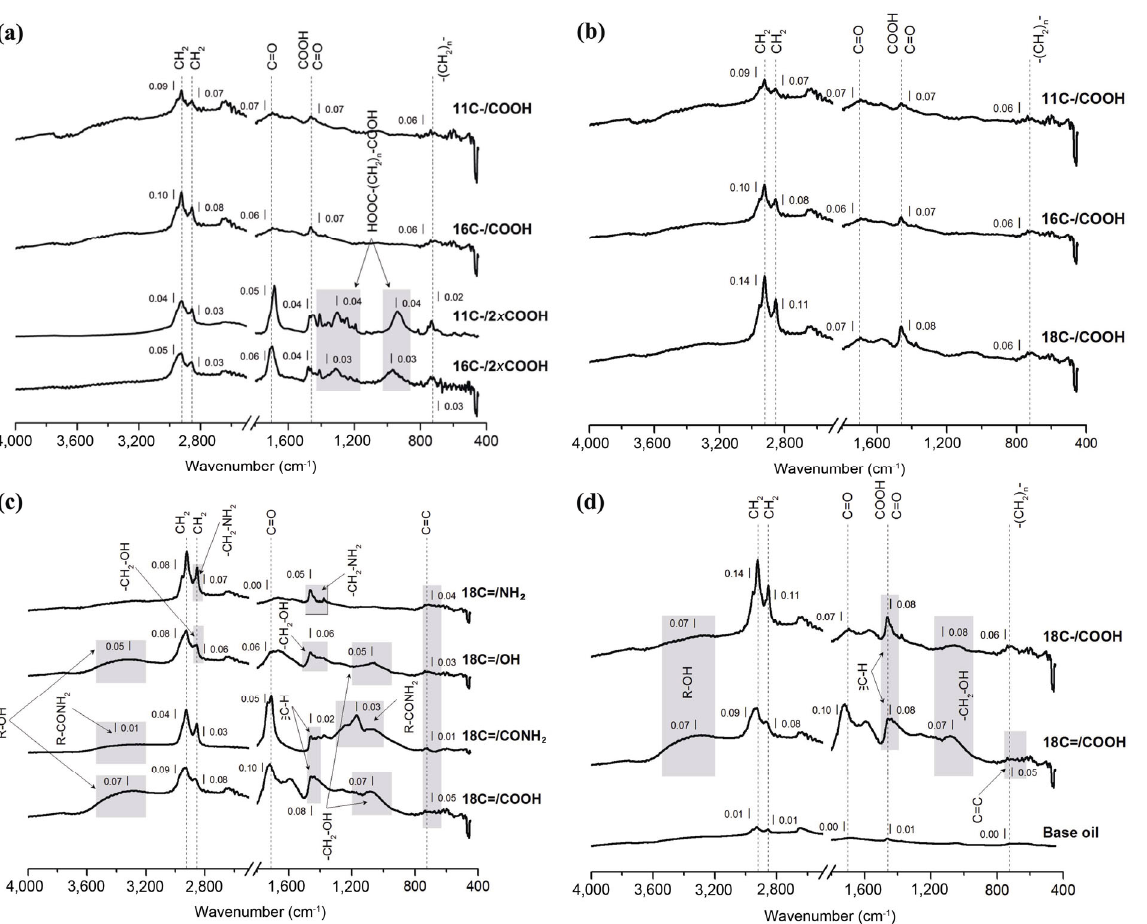
Fig. 5 ATR-FTIR spectra of steel discs after tribological tests at 25 ℃ with base oil and a mixture of base oil and additives having different (a) numbers of COOH groups; (b) chain lengths; (c) polarities of the functional groups; and (d)